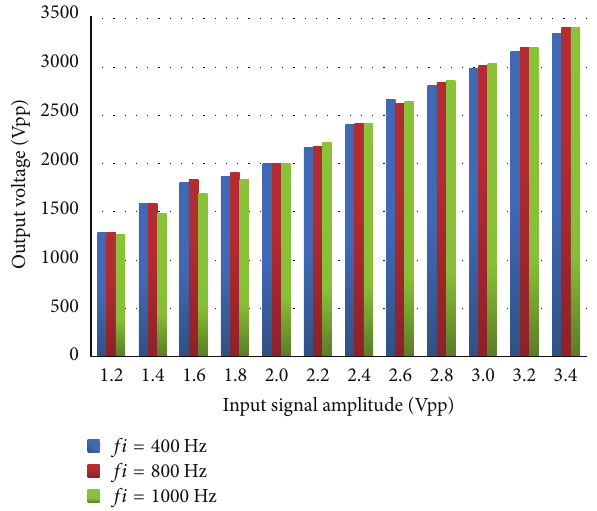
Figure 8: Linearity of power amplifier